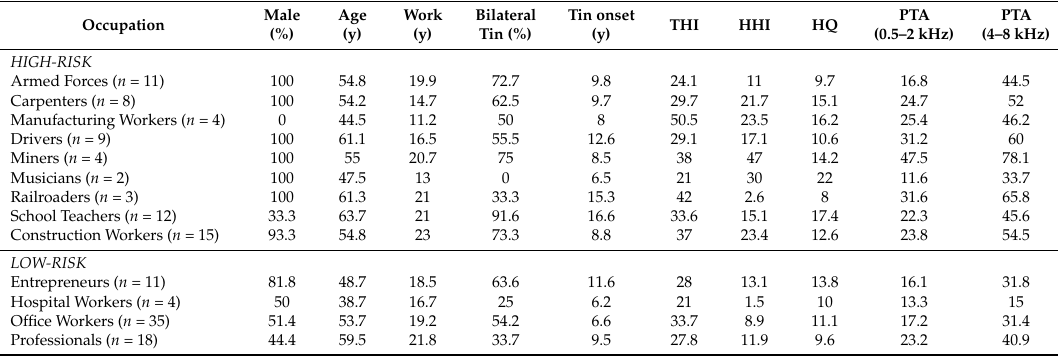
Table 4. Demographics, tinnitus characteristics, questionnaire scores, and hearing loss metrics among job types. A, upper part of the table: jobs of patients in the HIGH-RISK group; B, lower part of the table: jobs of individuals in the LOW-RISK group. Occupation Male (%) Age (y) Work (y) Bilateral Tin (%) Tin onset (y) THI HHI HQ PTA (0.5–2 kHz) PTA (4–8 kHz) HIGH-RISK Armed Forces ( n = 11) 100